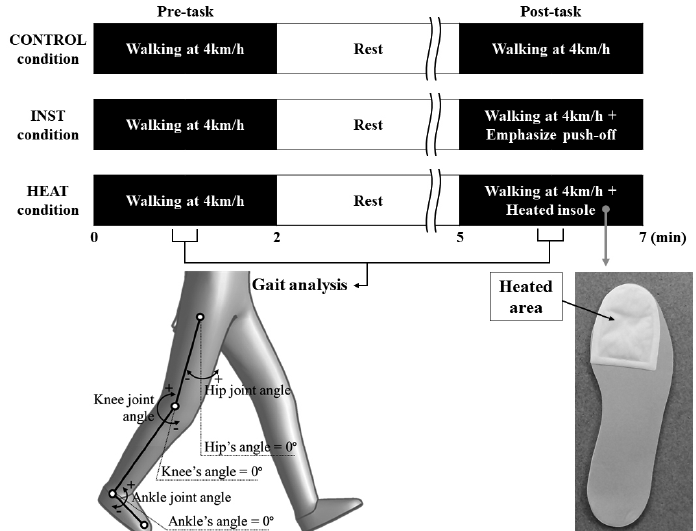
Figure 2. Experimental protocol and the definitions of each joint angle. (A disposable warmer was attached to the area from the ball of foot to the toe of the insole in post-task in HEAT condition. In the definitions of joint angles, positive values indicate flexion of hip and knee and ankle dorsiflexion. Further, negative values indicate extension of hip and knee and ankle plantarflexion). The order of the three conditions was randomized according to the participants. Par- ticipants unfamiliar with treadmill walking were given time to practice treadmill gait be- forehand.